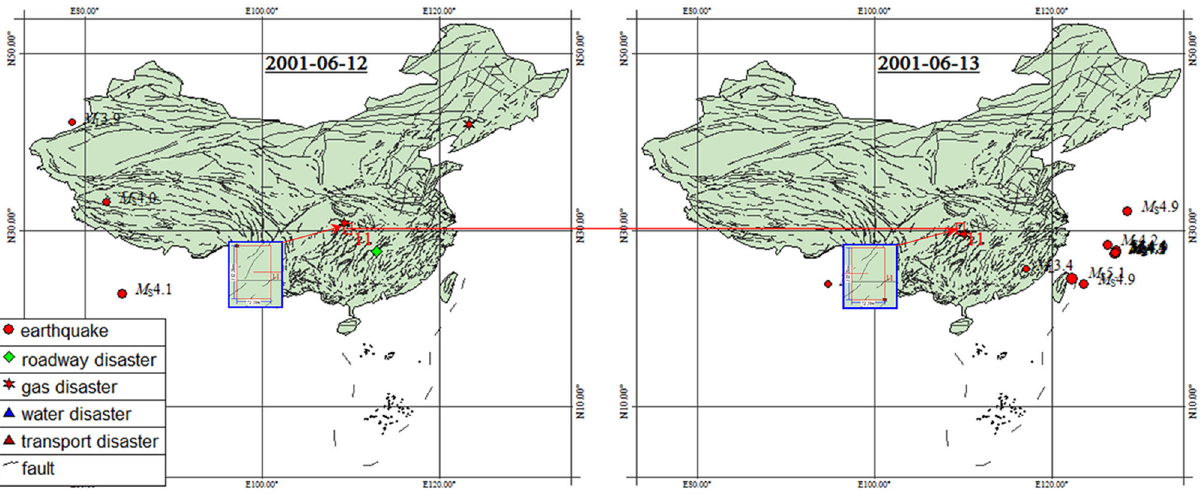
Fig. 3 Earthquakes and coal mine disasters occurring during the period from 12 to 13 June